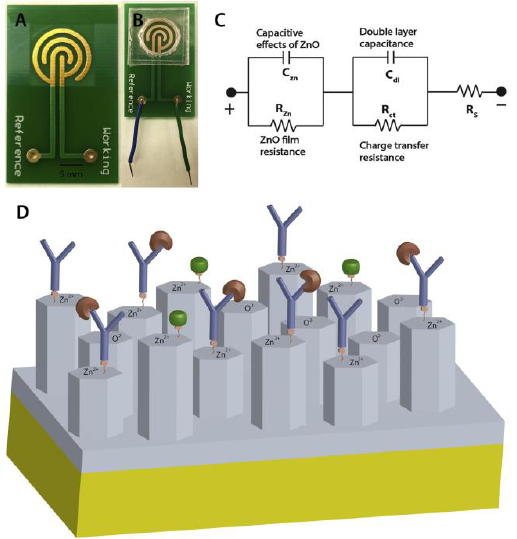
Figure 7. PCB based sensor developed for detection of Troponin-T as a cardiac biomarker: ( A ) PCB with electroplated gold electrodes and ZnO sputtered sensing site; ( B ) assembled sensor platform; polydimethylsiloxane (PDMS) manifold confines sample fluid on the ZnO sputtered sensing site; ( C ) electrical circuit model of the sensor, and ( D ) schematic of Troponin-T immunoassay on the nanocolumnar ZnO surface. The width of all the electrodes and the gap between each was 1 mm. Reproduced with permission from [49], Copyright 2016 Elsevier .